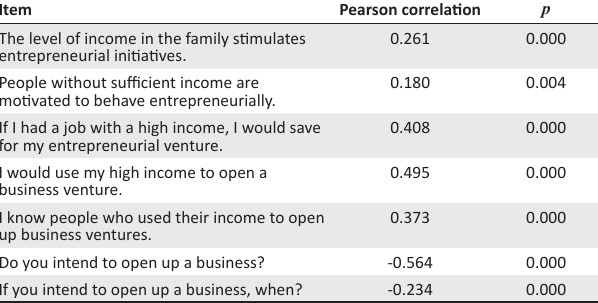
TABLE 9: Correlation between income and entrepreneurial intentions.